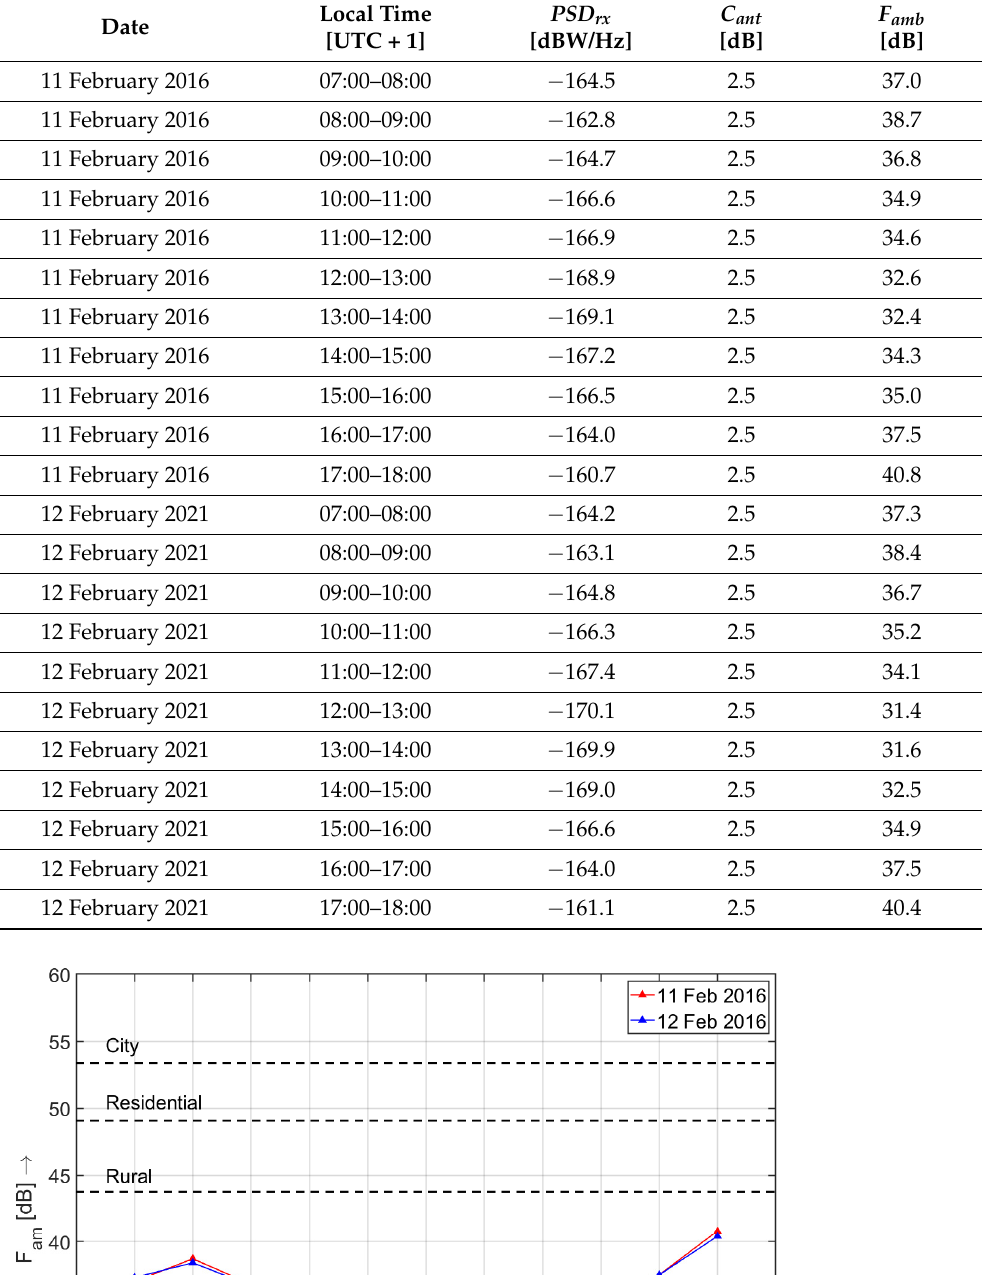
Table 1. Measured median ambient noise factor F AM .